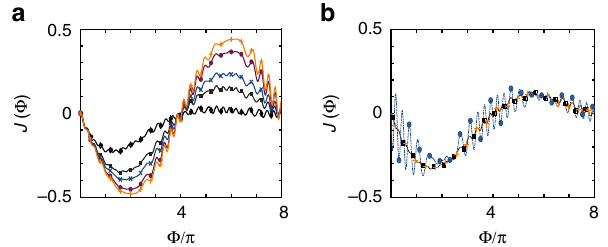
Figure 5 | Effect of dephasing and interactions on the current profile. Current as a function of F for a system with N ¼ 10, with parameters o (cid:2) 1 J ¼ 40 t (cid:2) 1 ; t L (cid:2) t R ¼ 5 (cid:6) 10 (cid:2) 3 t ; D ¼ 1 : 01 t and t L ¼ 0 : 1 t . ( a ) Different values of k ¼ g ¼ [0.02, 0.008, 0.005, 0.002, 0.0008] (diamonds, squares, crosses, circles and pluses; ordered top to bottom for short times). ( b ) Fixing k ¼ 0.01 and g ¼ 0.05, and including the presence of a nearest- neighbour interaction (equation 6), for U / t L ¼ [0.01, 0.1, 1] (orange/ crosses/dash, black/squares/solid and blue/circles/dot dash).